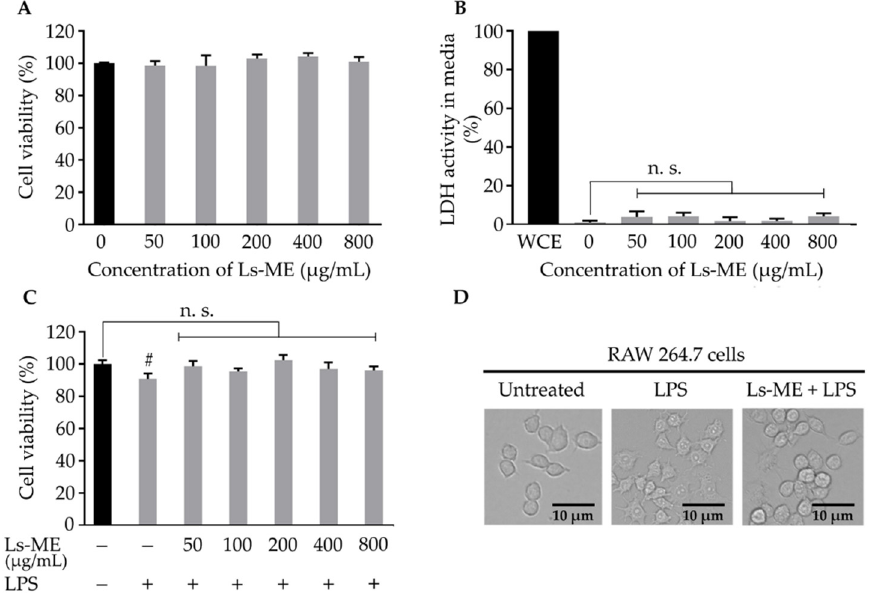
Figure 1. The e ff ects of Ls-ME on the viability and morphology of LPS-stimulated RAW 264.7 cells. Cells were treated with various concentrations of Ls-ME for 24 h. ( A ) Cell viability and ( B ) LDH activity were examined. LDH activity in whole-cell extract (WCE) is represented as 100% activity and used as the control. The e ff ects of Ls-ME on cell viability after LPS stimulation are demonstrated in ( C ). The morphology of cells was examined in three groups: the untreated group with medium only, group treated with LPS (LPS-1 µ g / mL) for 18 h, and Ls-ME + LPS pretreatment group (Ls-ME 200 µ g / mL for 24 h) (LPS-stimulation was performed for 18 h). The morphology of the cells is shown in ( D ). The results are represented as mean ± SD (n = 6). Scale bar indicates 10 µ m in ( D ); # p < 0.05; n. s., not significant in comparison with the untreated group.